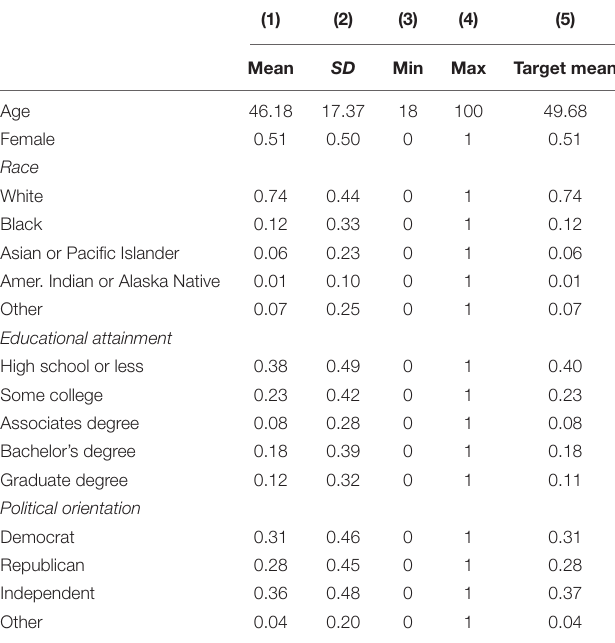
TABLE 1 | Summary statistics ( N =